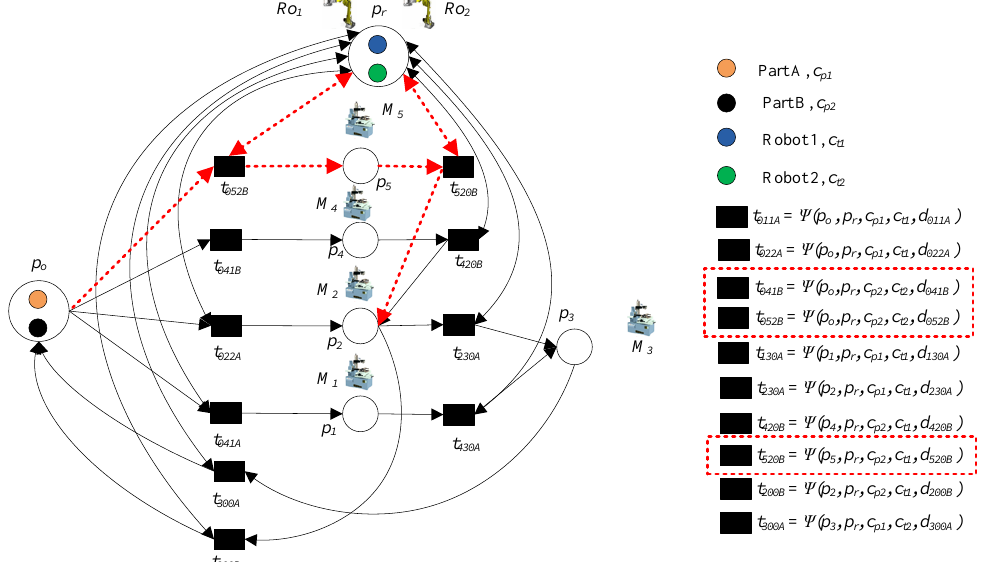
Figure 5. An ICTPN for the reconfigured system by addition of a new machine.